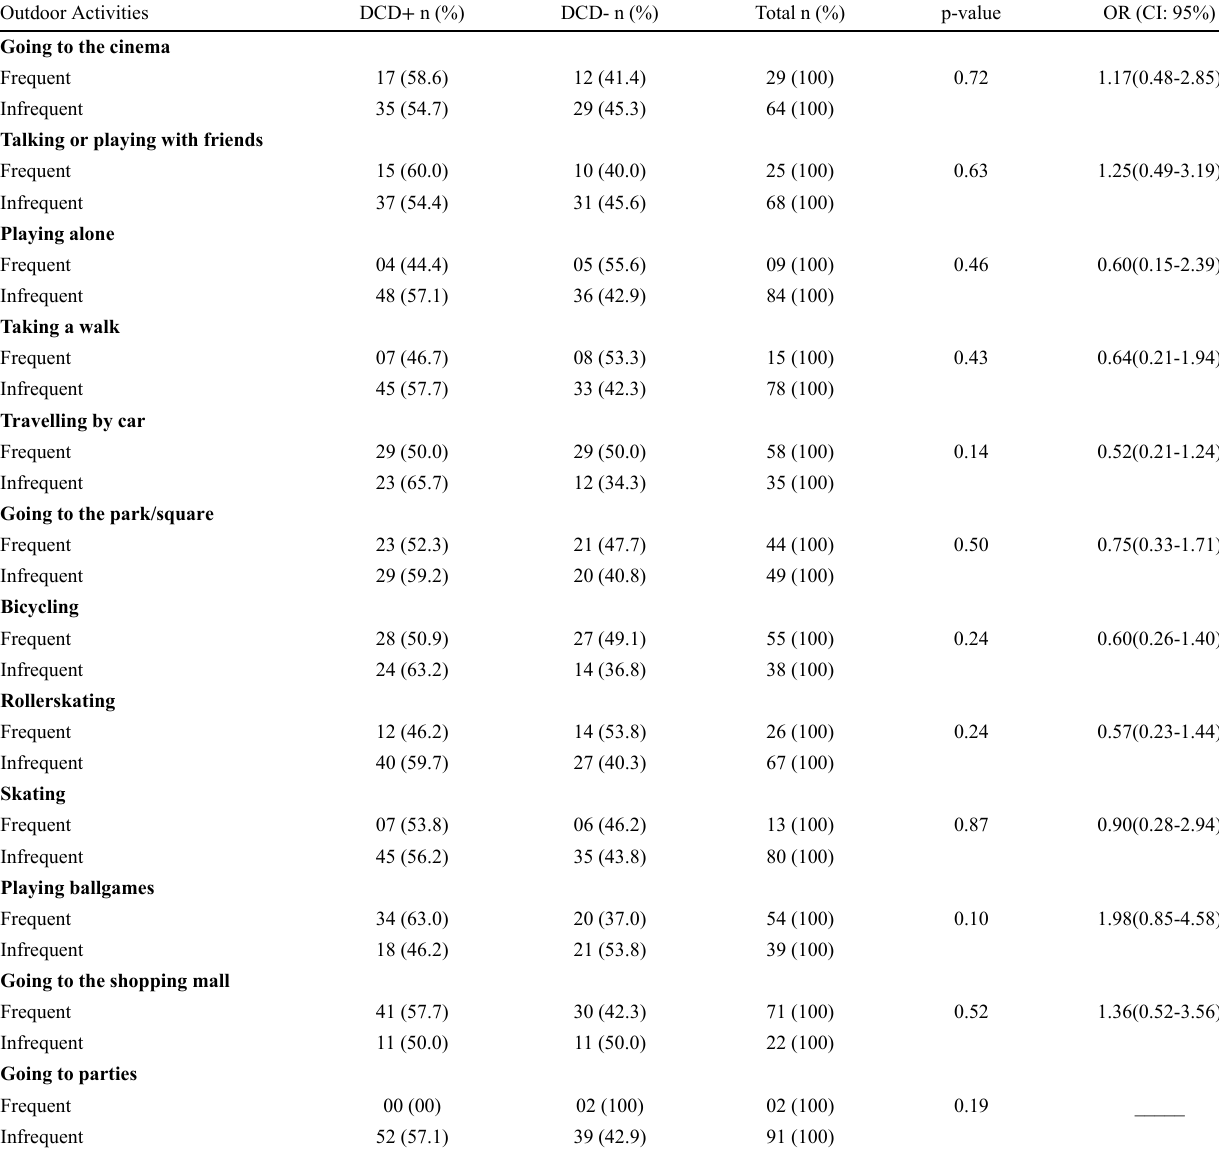
Table 2 - Analysis of the association between lifestyles through the activities performed at home and positive or negative DCD classification among stu- dents Outdoor